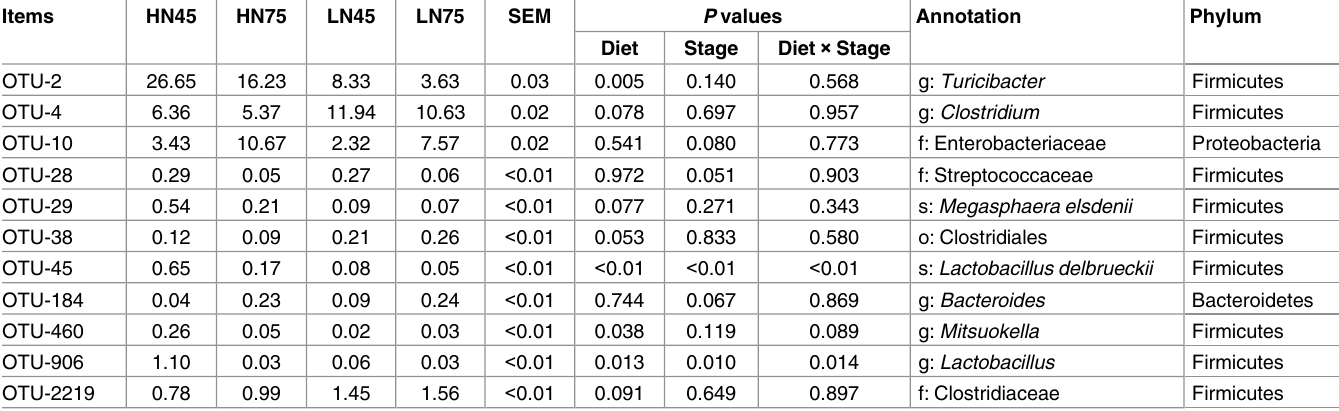
Table 5. Effect of diet and pregnancy stage on OTU levels (%) in the ileal bacterial communities of Huanjiang mini-pigs * .